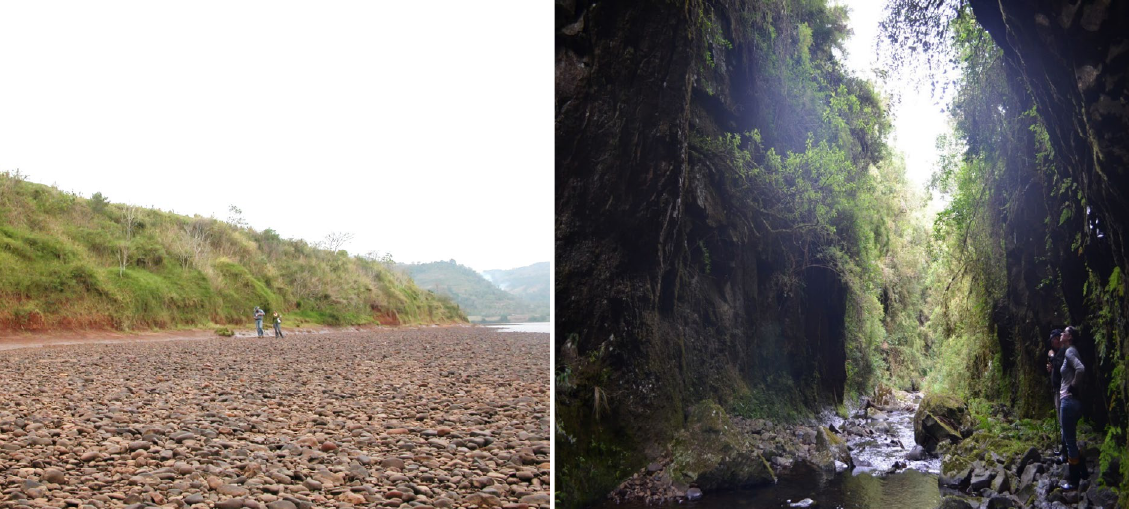
Figure 8. Left: pebbles and cobbles in the Upper Uruguay River (Caxambú do Sul County; Santa Catarina). Right: exposed walls, fallen rocks, cobbles and pebbles in Santa Bárbara stream (Bom Jardim da Serra County, Santa